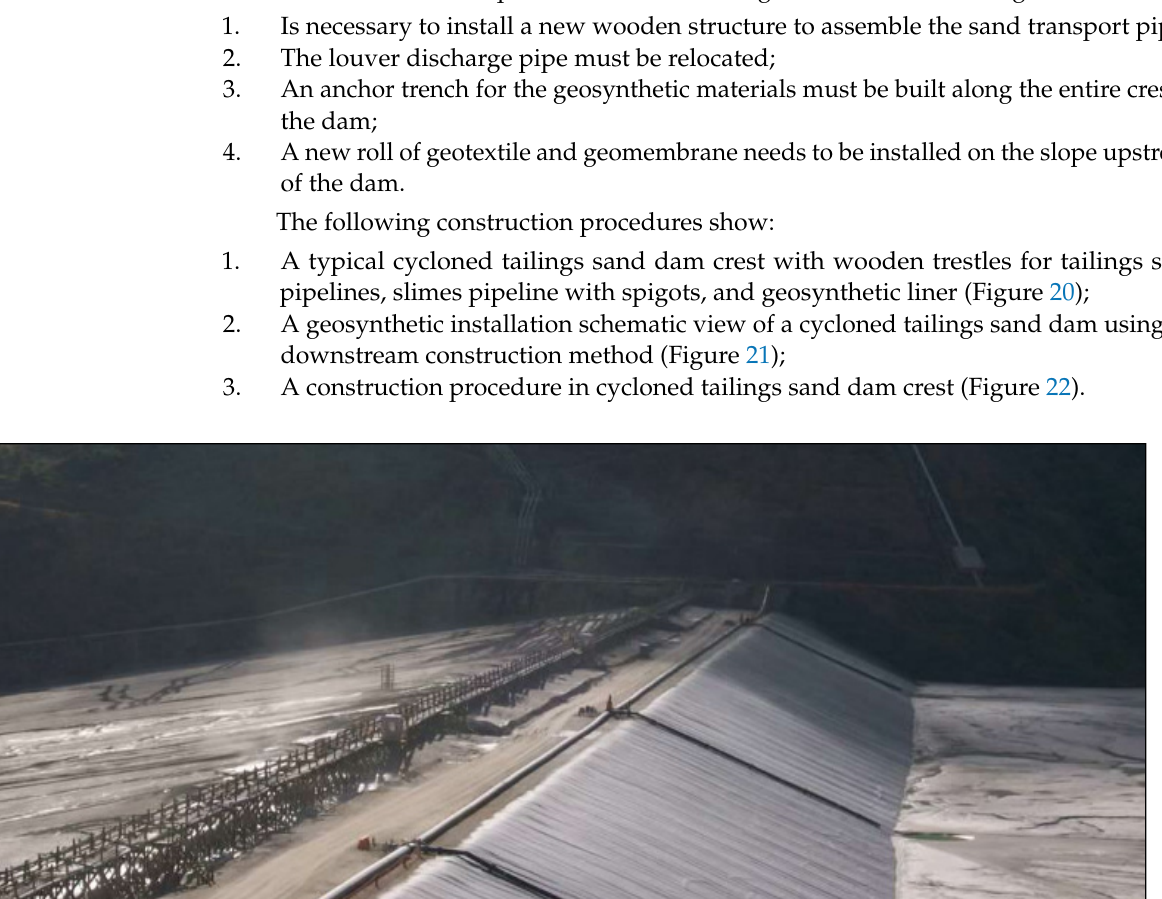
Figure 21. Cycloned tailings sand dam upstream face waterproofing construction detail.